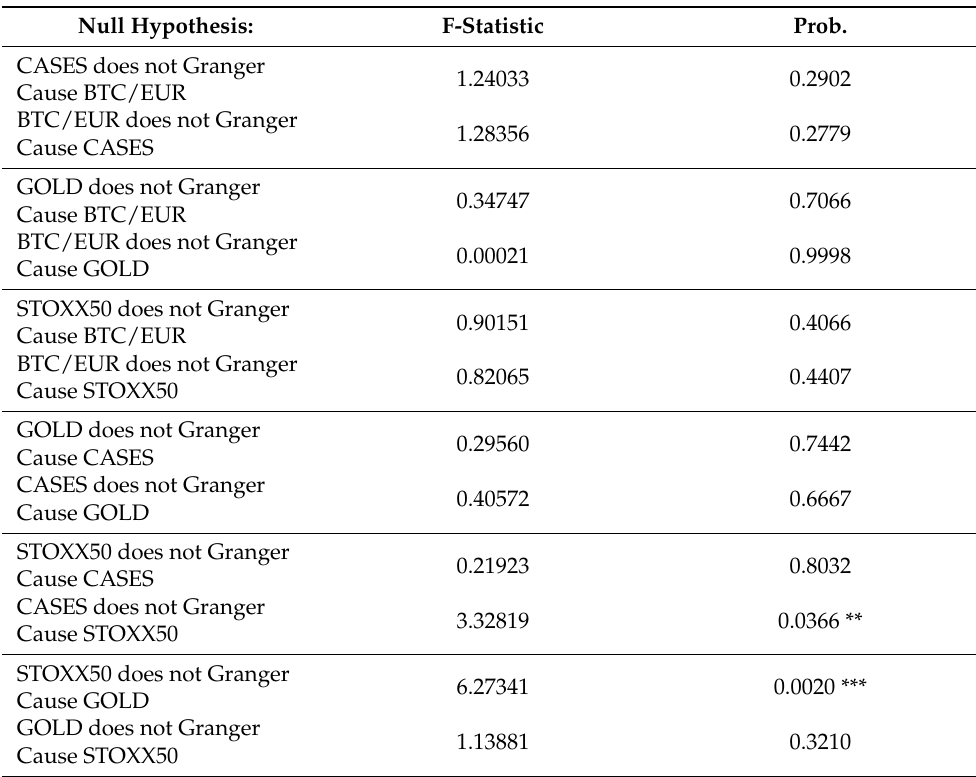
Table 4. Pairwise Granger causality